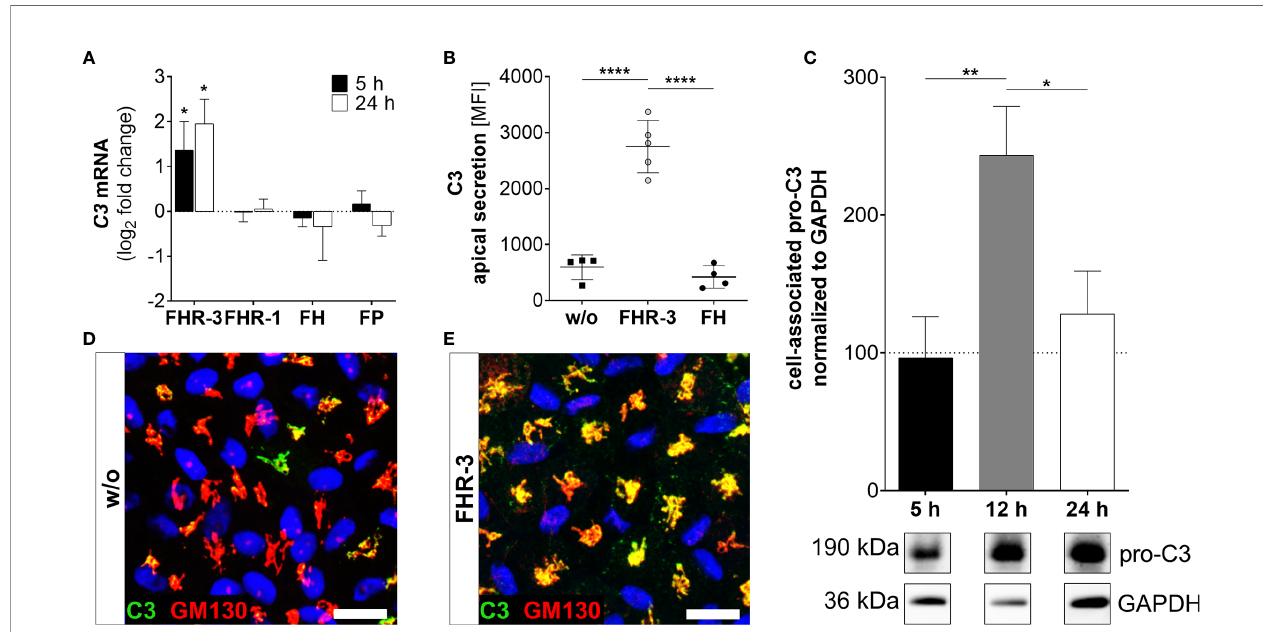
FIGURE 3 | FHR-3 increased C3 expression and secretion in ARPE-19 cells. (A) C3 mRNA expression was increased 5 h and 24 h after apical treatment of ARPE- 19 cells with FHR-3, but not after incubation with FHR-1, FH or FP, respectively. This effect could be con fi rmed at the protein level showing an FHR-3-dependent increase (B) in C3 protein secretion after 24 h, (C) elevated pro-C3 protein (190 kDa) in ARPE-19 cell lysates in Western blots after 12 h, and (D, E) increased intracellular C3 protein levels by immuno fl uorescence using anti-C3 (green) and anti-GM130 (red, cis-Golgi marker) antibodies after 12 h treatment. C3 was co- localized with the cis-Golgi (yellow). Scale bars 40 µm. w/o untreated control [ (A, C) dotted line]. Mean with standard deviation is shown. Full Western blot in Supplementary Figure 1K . ****p < 0.0001, **p < 0.01, *p < 0.05. (A) Wilcoxon matched-pairs signed rank test (n = 3); (B, C) Ordinary one-way ANOVA, Turkey ’ s multiple comparisons test (n =